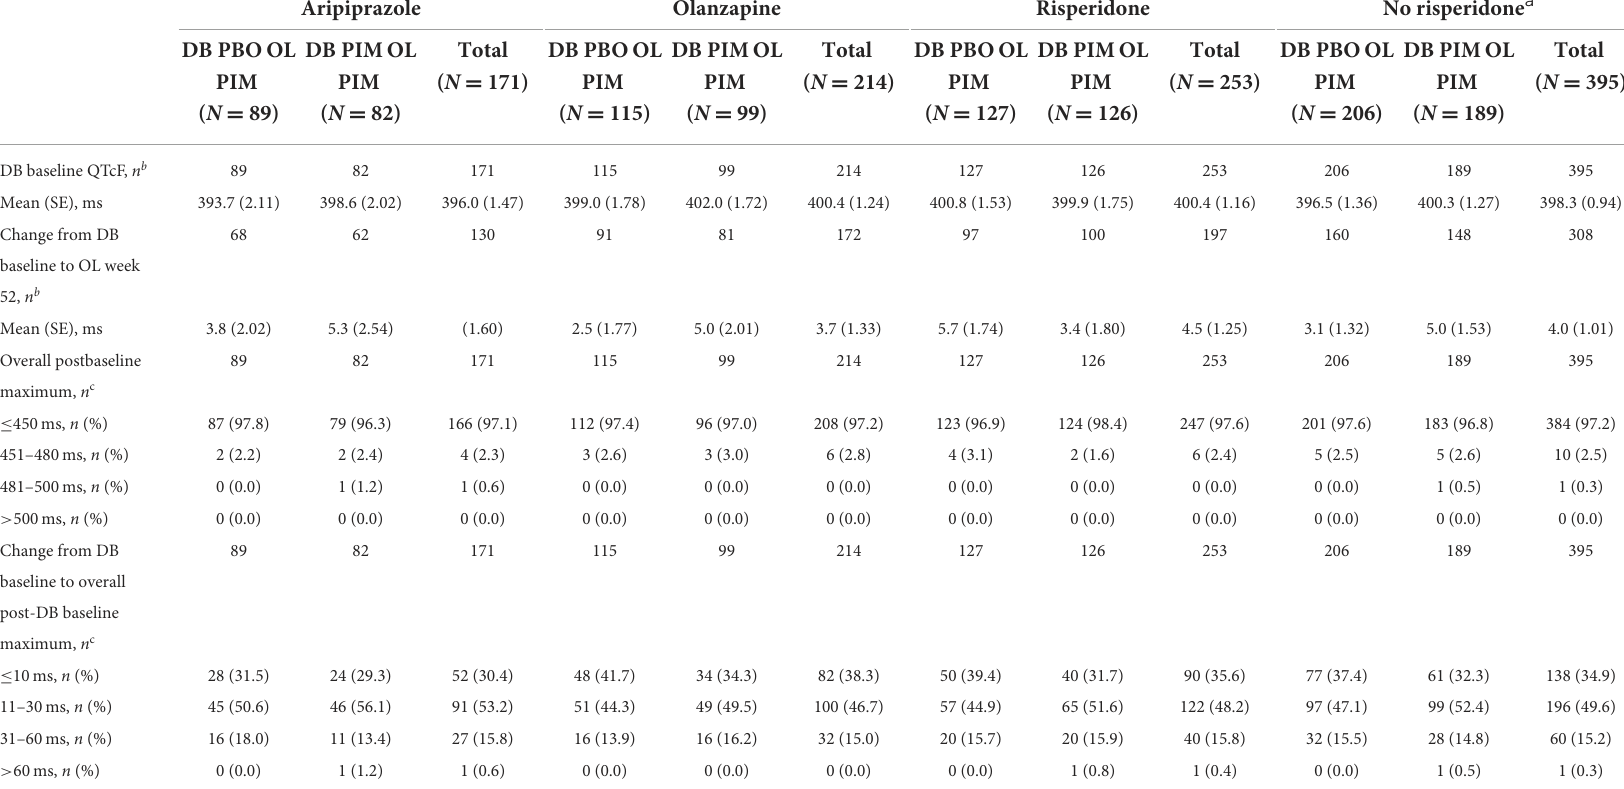
TABLE 4 Study 035: QTcF at double-blind baseline and